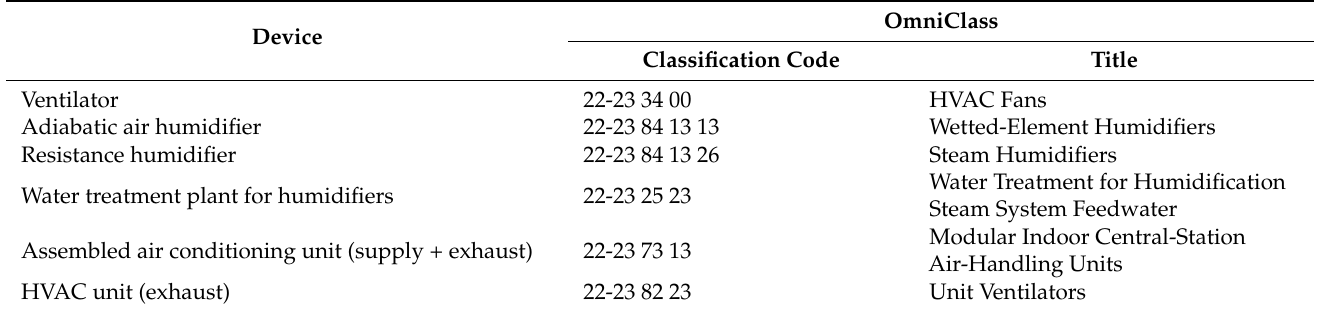
Table 2. Classification codes of individual devices according to OmniClass. Source: authors according to